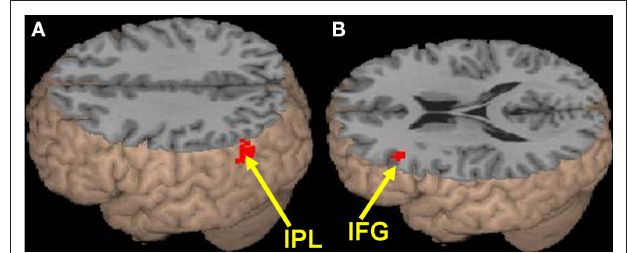
FIGURE 1 | The effects of semantic association strength. (A) Stronger association produced greater activation for the related pairs in left inferior parietal lobule (IPL, BA 39, 40). (B) Weaker association produced greater activation for the related pairs in the mid ventral portion of left inferior frontal gyrus (IFG, BA 45).